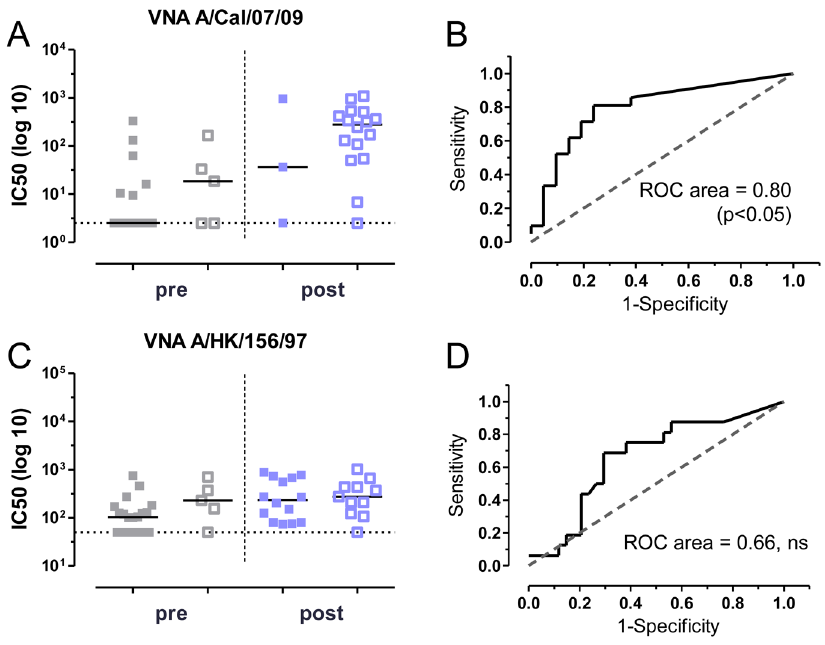
Figure 4. Serum VNA titers correlate with protection against H1N1 but not H5N1 challenge. VNA titers against ( A ) A/California/07/2009 (H1N1) and ( C ) A/Hong Kong/156/97 (H5N1) were determined. Titers for mice that survive challenge (open squares) and mice that succumb to infection (closed squares) are presented separately for pre-vaccination (pre) and post-vaccination (post) sera. Assay background level is indicated with dashed line in panels A and C. Vaccine homologous H1 VNA titers are higher in post-vaccination serum (p , 0.001, t-test). H5 VNA titers are detectable in some pre-vaccination samples and are higher in post-vaccination serum (p , 0.001, t-test). ROC curves were calculated to assess the correlation ( B ) between H1N1 A/California/07/2009 VNA and protection against H1N1 A/Netherlands/602/2009 challenge and ( D ) between H5N1 A/Hong Kong/156/ 97 VNA and protection against H5N1 A/Hong Kong/156/97 challenge. H1N1 VNA correlates with protection against homologous H1N1 challenge (ROC area=0.80, p , 0.05, 95% CI 0.66–0.94). The positive correlation between H5 VNA and H5 protection does not reach statistical significance (ROC area=0.66, 95% CI=0.496–0.82).